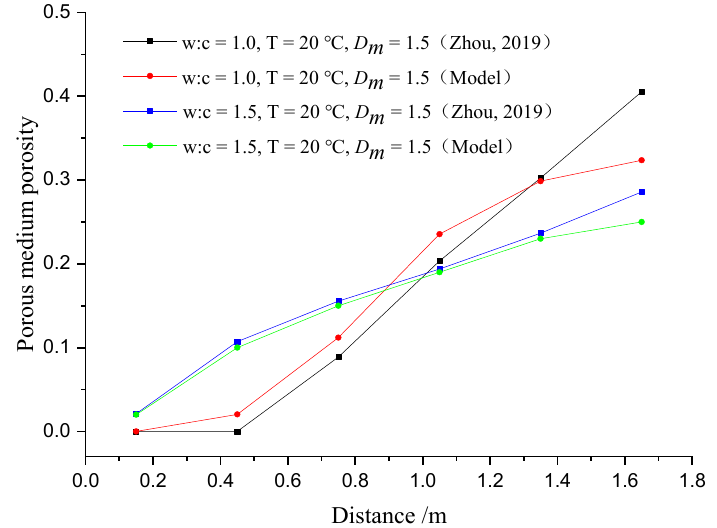
Figure 2. The variation law of porosity of pore media with distance at each test point with different water–cement ratios in the test and model.